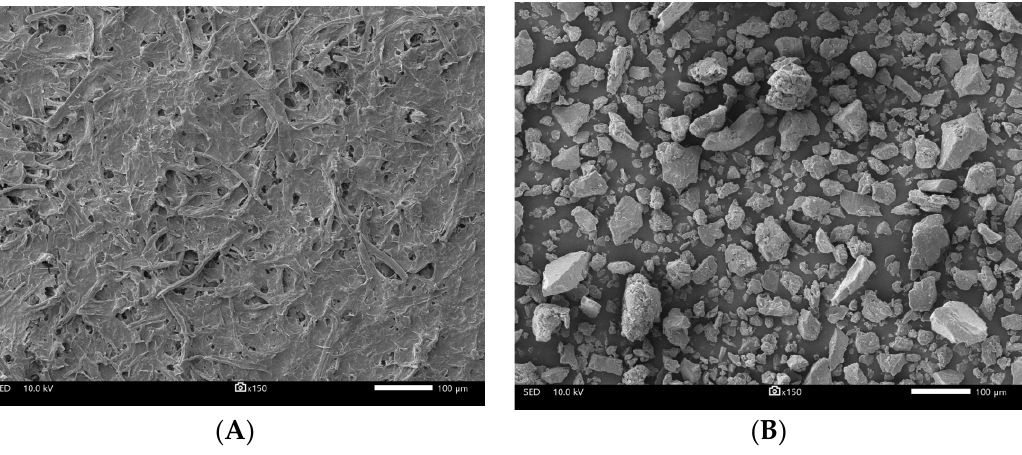
Figure 2. ( A ) SEM image the NCC suspension in water. ( B ) NCC powder prior to sieving.